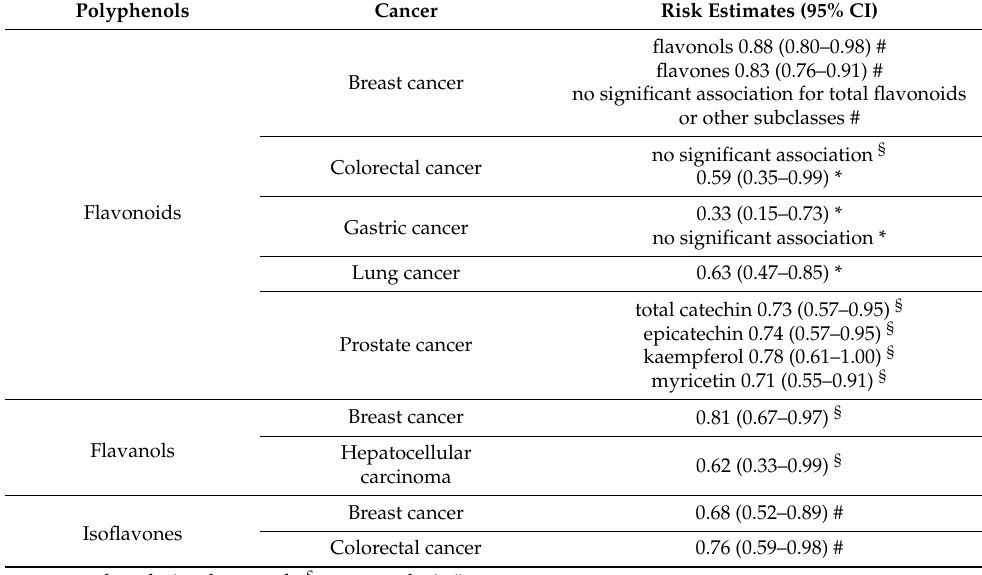
Table 4. Epidemiological Studies: dietary polyphenol intake and cancer risk (Adapted from [95]).